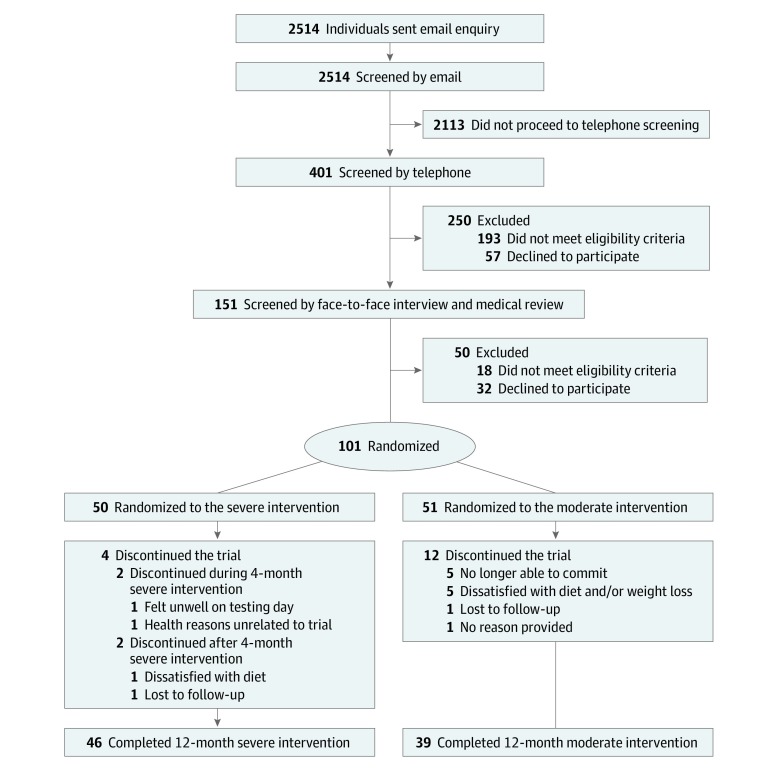
Trial Flow Diagram The moderate intervention involved a food-based diet with a 25% to 35% energy restriction for a total of 12 months (52 weeks). The severe intervention involved total diet replacement with 65% to 75% energy restriction for 4 months (16 weeks) or until a body mass index (calculated as weight in kilograms divided by height in meters squared) of no lower than 20 was reached, whichever came first, followed by moderate energy restriction until 12 months (52 weeks).